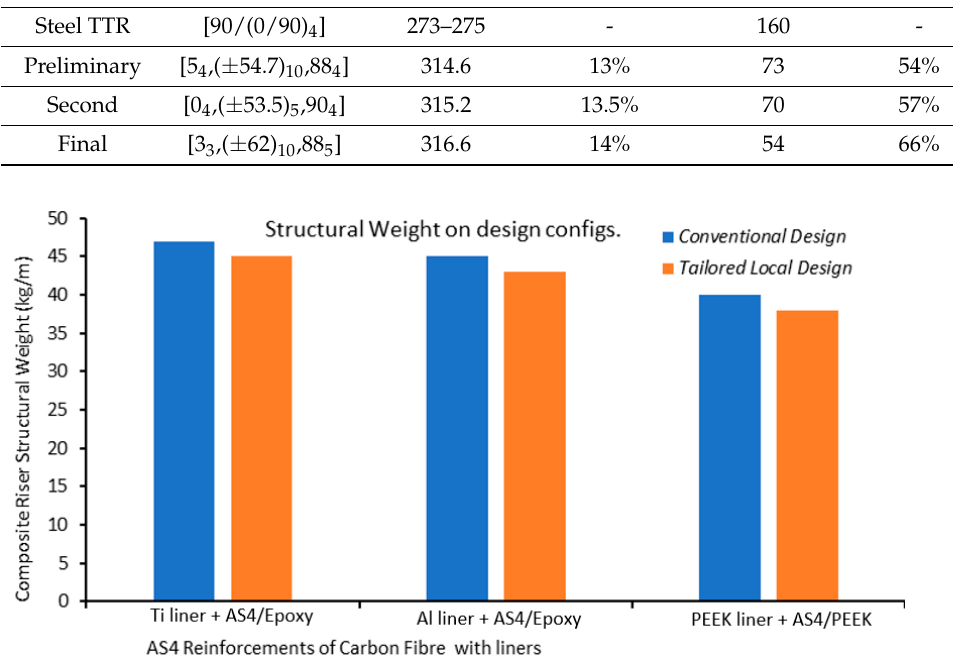
Figure 22. Comparative study of different designs using structural weights on design configurations. Table 13. Comparison of deep water TTR steel riser under 2000 m water depth against its structural weight.